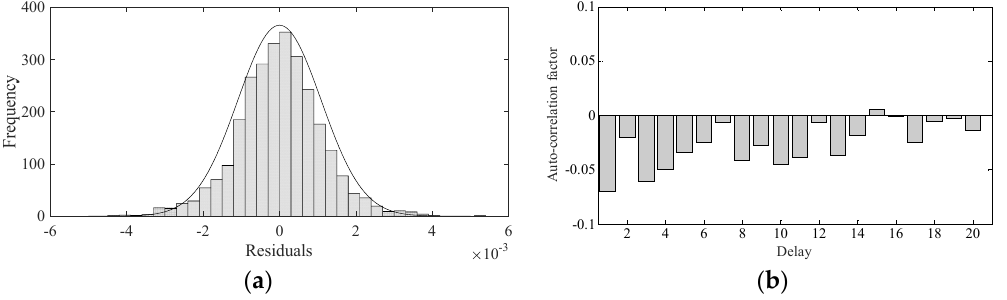
Figure 10. ANOVA assumption tests for distribution test: ( a ) distribution test; ( b ) independence test.